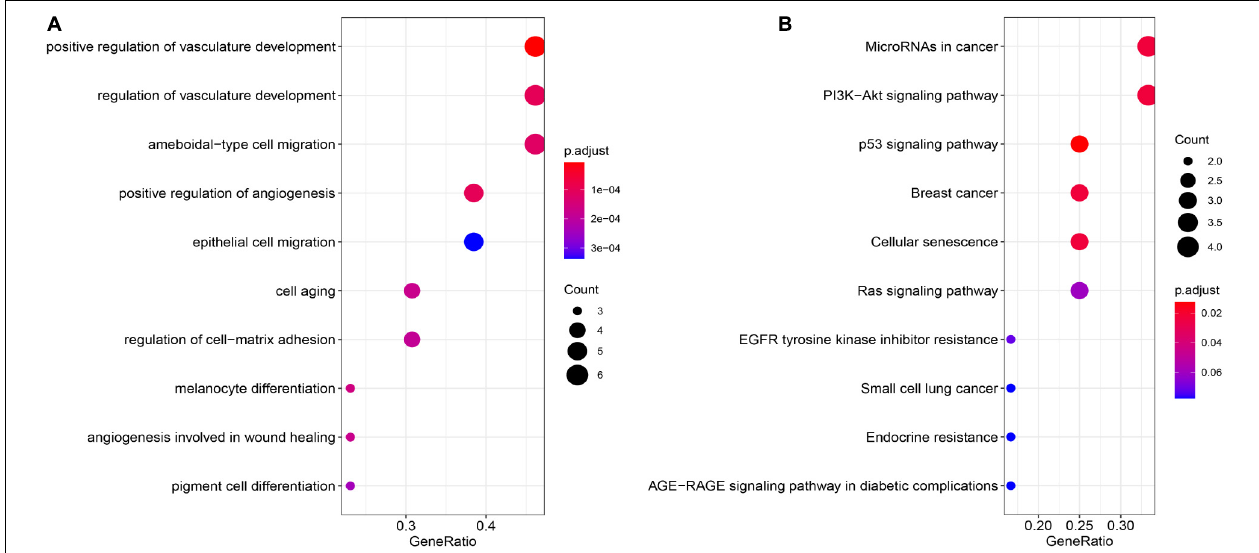
FIGURE 4 | GO and KEGG pathway enrichment analyses. (A) GO enrichment analysis of the module genes. (B) KEGG pathway enrichment analysis of the module genes. GO, Gene Ontology; KEGG, Kyoto Encyclopedia of Genes and Genomes.